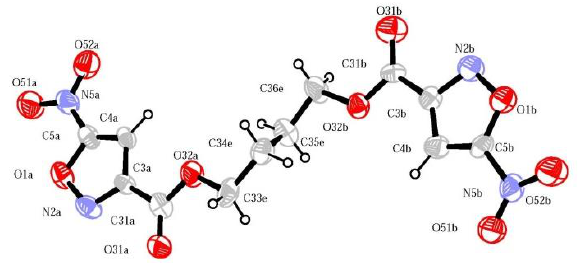
Figure 1. The molecular structure of compound 3c . Displacement ellipsoids are drawn at the 50% probability level; H atoms are presented as spheres with an arbitrary radius.